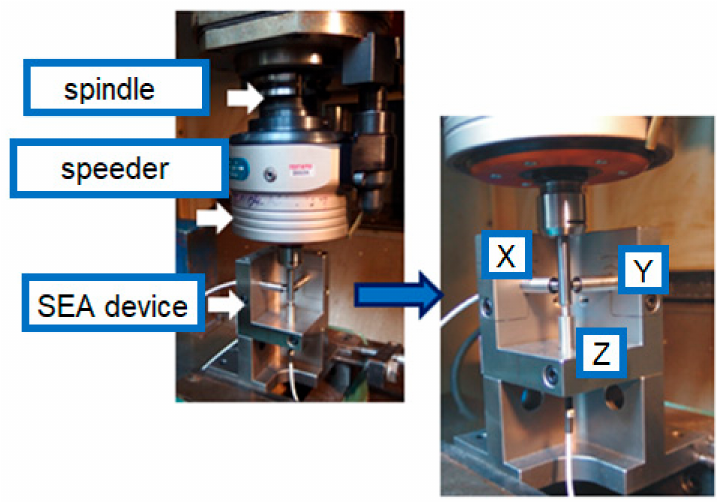
Figure 75. Test stand of the speed multiplier.